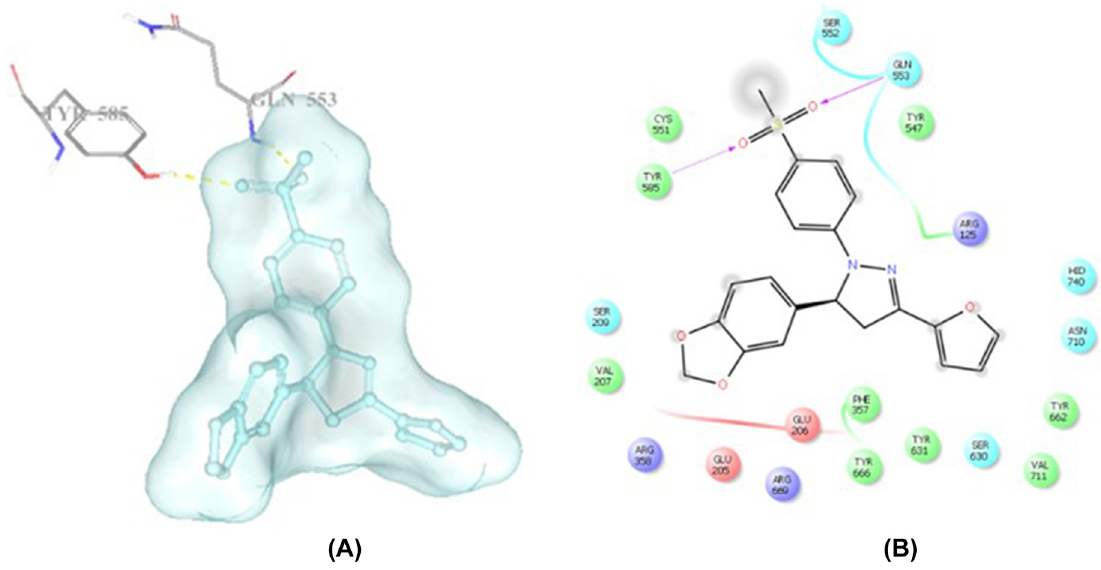
Figure 3: Docking pose (A) and interactions (B) of compound 2 in the active site of DPP-4 (PDB code: